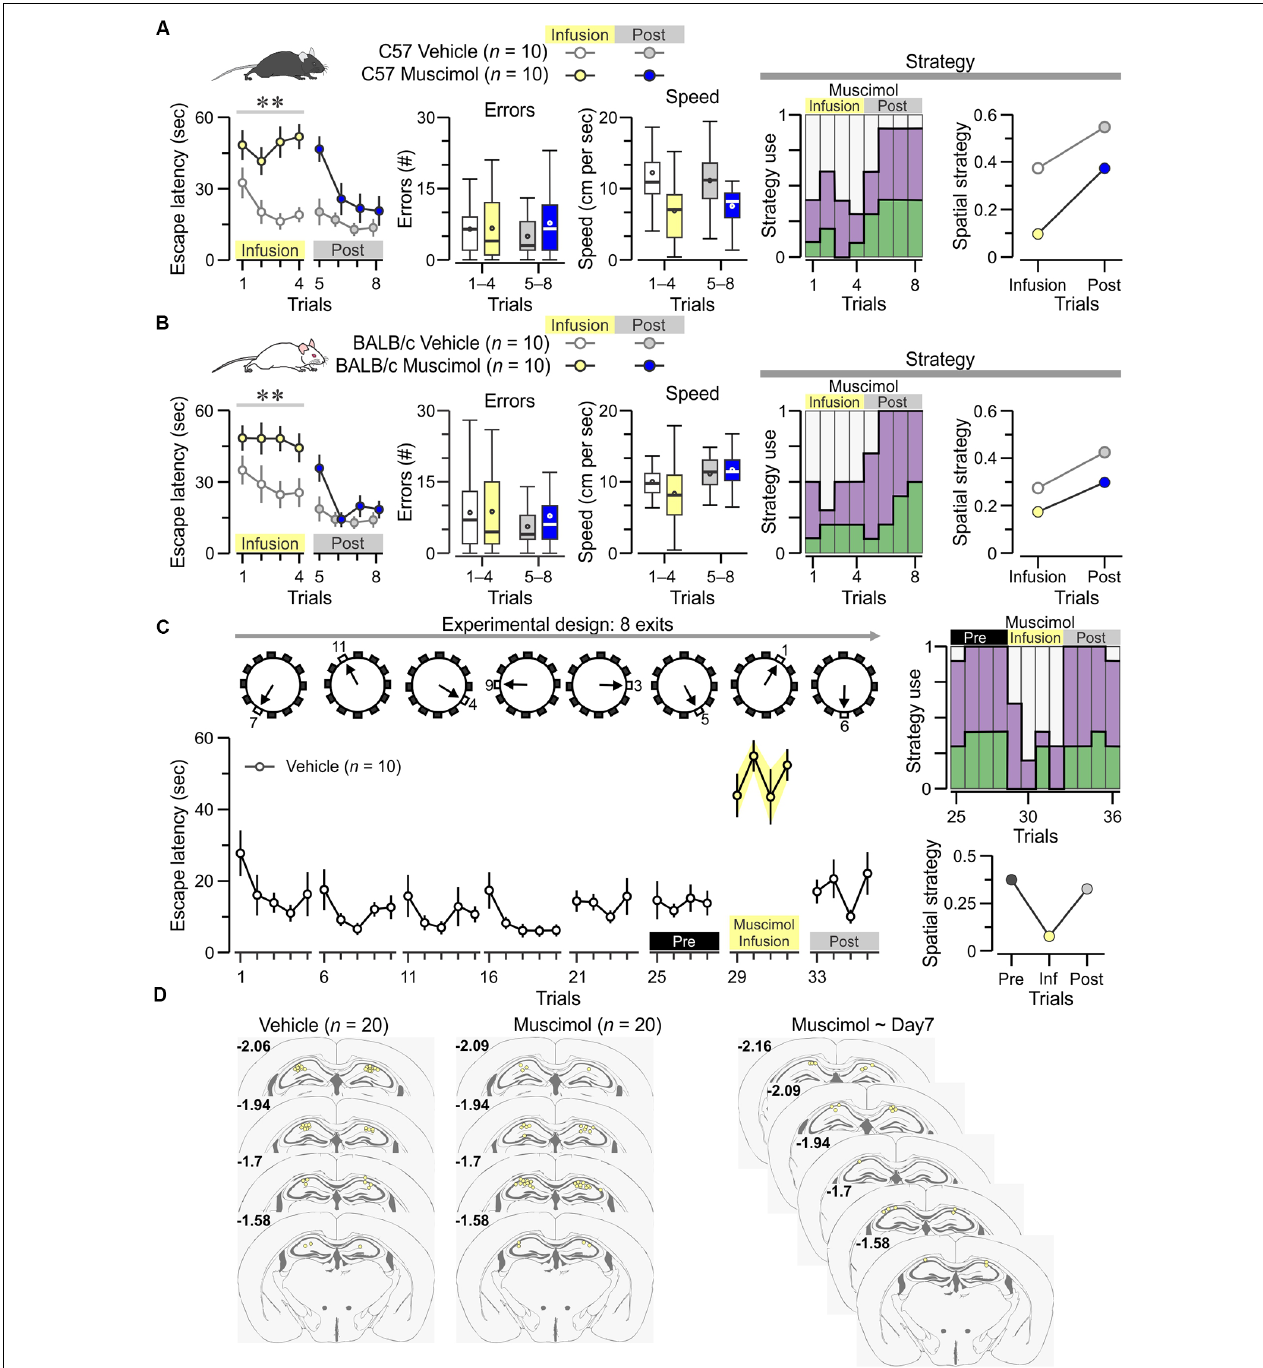
FIGURE 6 | Dorsal hippocampal CA1 region is required for acquisition of the PPT. (A) Left , plot of escape latency [mean ± standard error of the mean (SEM)] across trials for C57 mice ( n = 10 females) receiving bilateral injections of muscimol on trials 1–4 and vehicle injections on trials 5–8. Vehicle-treated animals ( n = 10) are used as controls. On trials 1–4, the muscimol group is unable to acquire the task ( F ( 1,3 ) = 26.7, ∗∗ P = 7.7 × 10 − 5 RMANOVA of log 10 transformed escape latencies). Middle , boxplots of the number of errors and the mean speed demonstrate no significant effect of muscimol. Right , Escape strategy analysis of the muscimol-infused group (colors as in Figure 4A ) show marked use of futile strategy on trials 1–4 (muscimol) and significant increase of spatial strategy on trials 5–8 (post-muscimol). (B) A similar study of BALB/c females (10 muscimol, 10 vehicle) with plot of escape latency ( left ) showing that, on trials 1–4, the muscimol-infused mice do not acquire the task ( F ( 1,3 ) = 10.98, ∗∗ P = 0.0038, RMANOVA of log 10 transformed escape latencies) but have a normal number of errors and mean speed ( middle ). Escape strategy analysis ( right ) of the muscimol-infused group shows they mostly use a futile strategy on trials 1–4 (muscimol) and increase their use